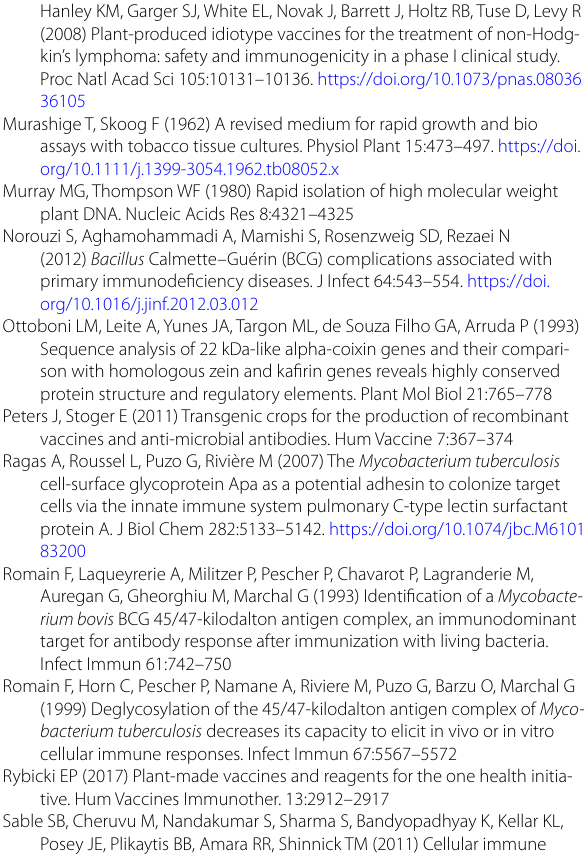
tabacum using a potato virus X-based vector. Tuberculosis 86:263–267. https